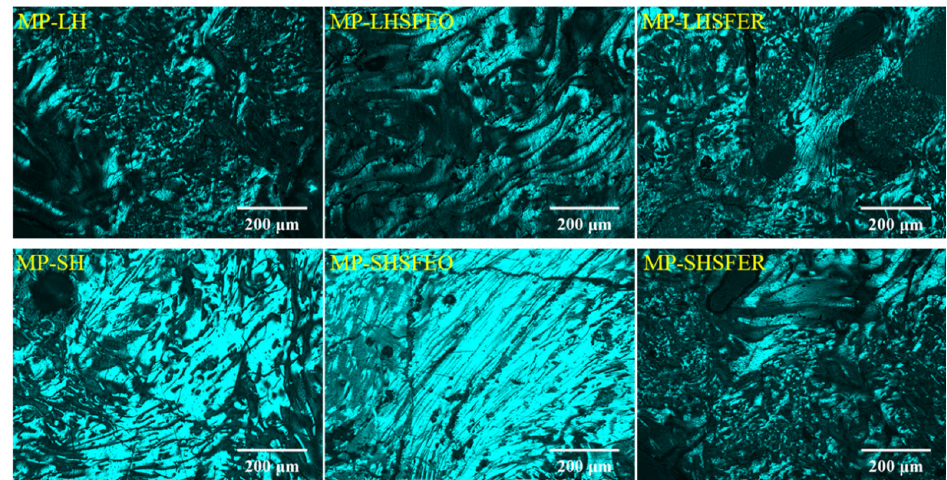
Figure 17. Polarized microscope images of several mesophase pitches.